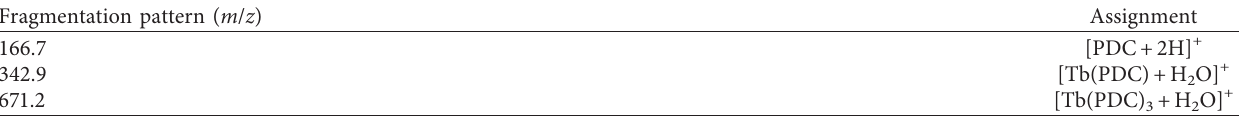
Table 2: Complexes confirmed by the electrospray ionization-mass spectrometry (ESI-MS) method. Fragmentation pattern ( m / z